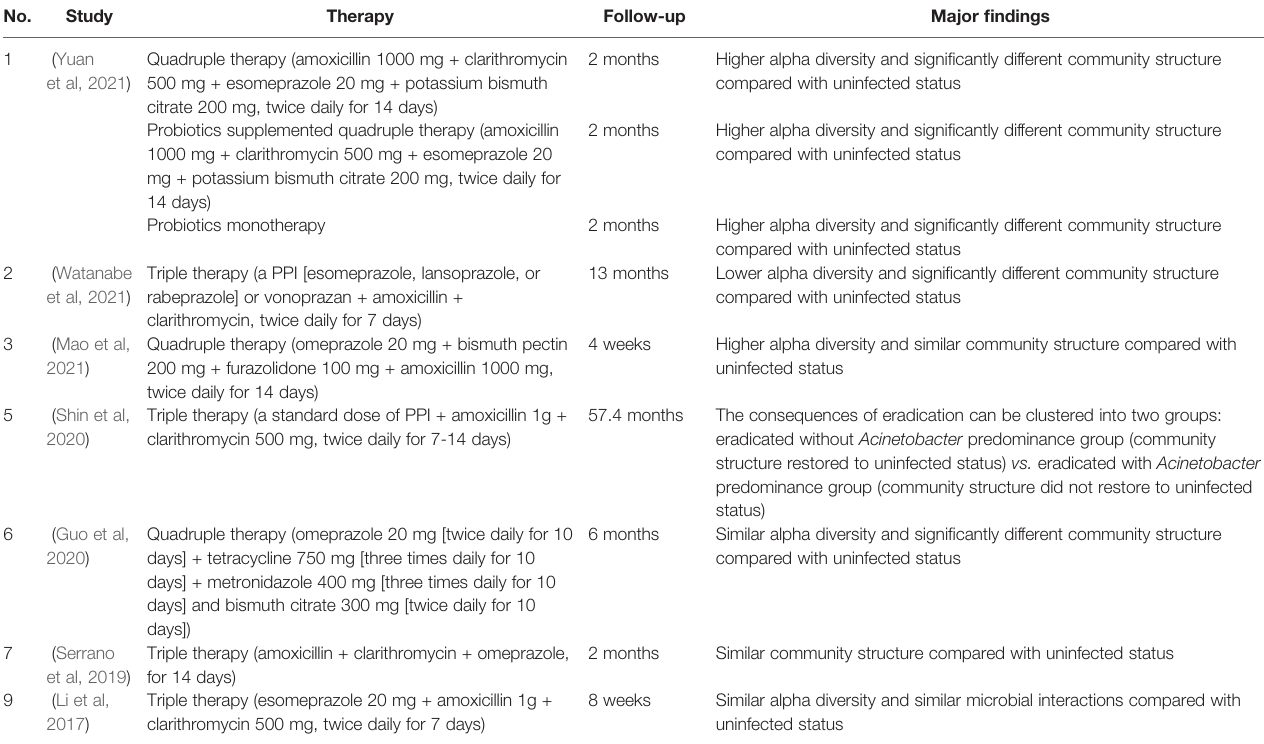
TABLE 5 | Comparison of gastric microbiota between after eradication and uninfected